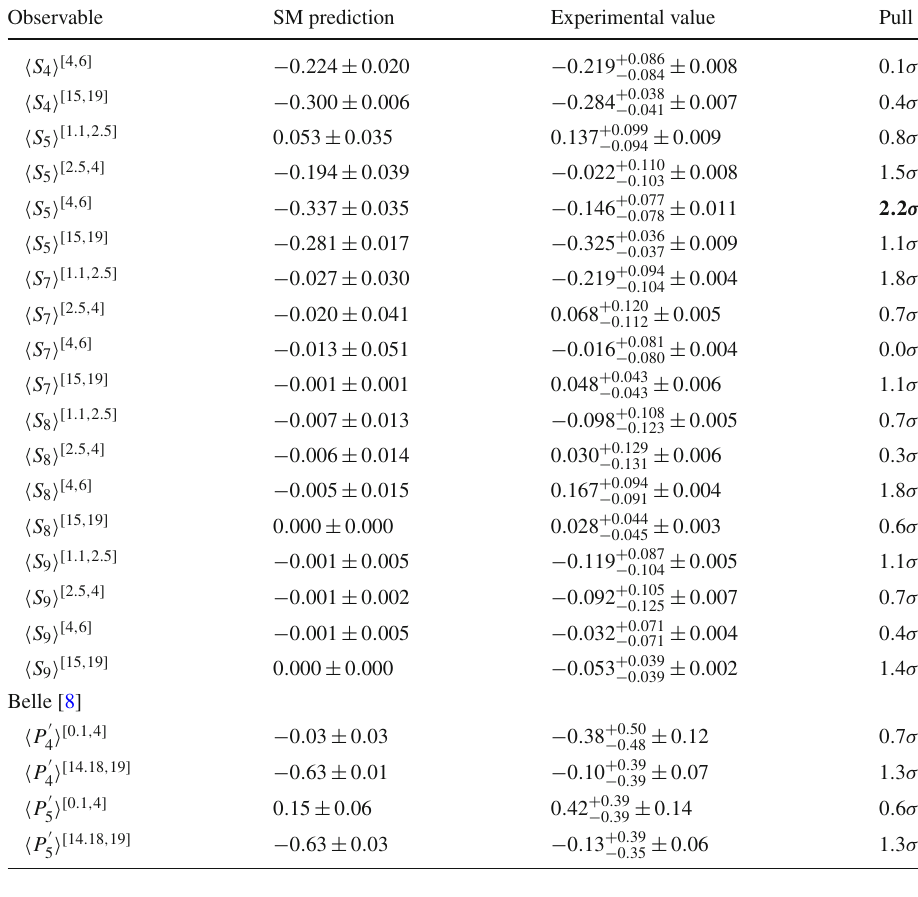
Table 8 Angular observables of B 0 → K ∗ 0 μ + μ − included in the global